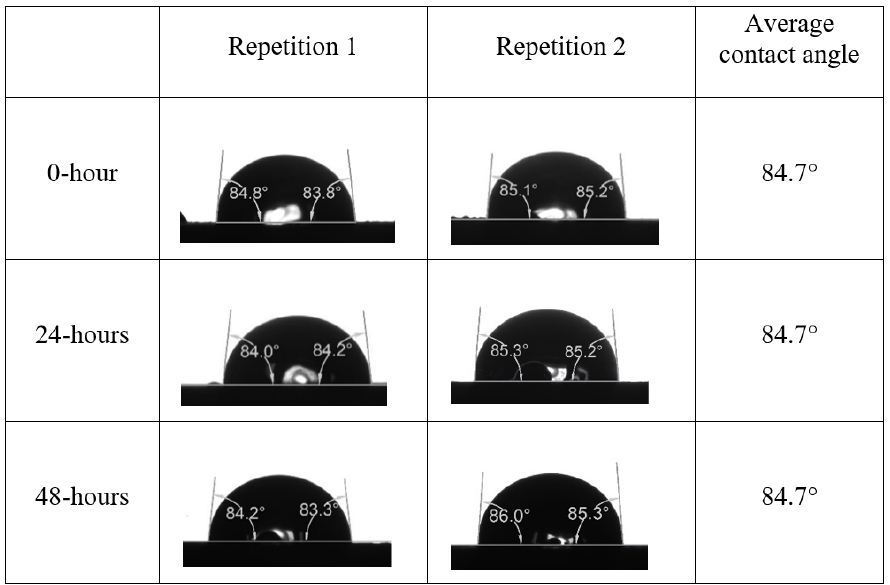
Figure A1. Dynamic Contact Angle Measurement Results for Sea-water (35,000 ppm).